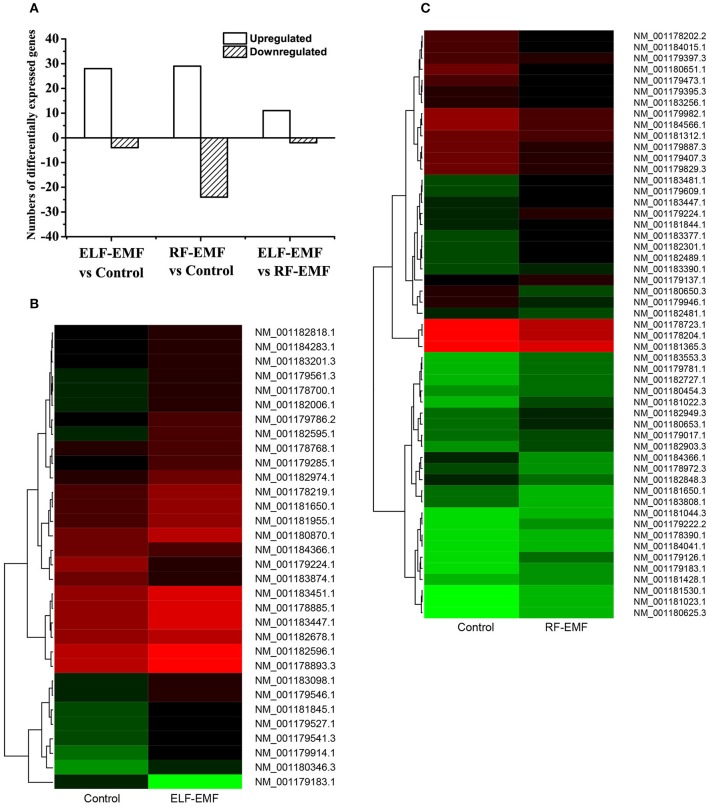
Analysis of DEGs. (A) Summary of the numbers of DEGs between the ELF-EMF exposure group, RF-EMF exposure group, and control group. (B) Cluster analysis of DEGs between the ELF-EMF exposure group and the control group. Each column represents an experimental condition, and each row represents a gene. Expression differences are shown in different colors. Red indicates upregulation, and green indicates downregulation. (C) Cluster analysis of DEGs between the RF-EMF exposure group and the control group. Each column represents an experimental condition, and each row represents a gene. Expression differences are shown in different colors. Red indicates upregulation, and green indicates downregulation.